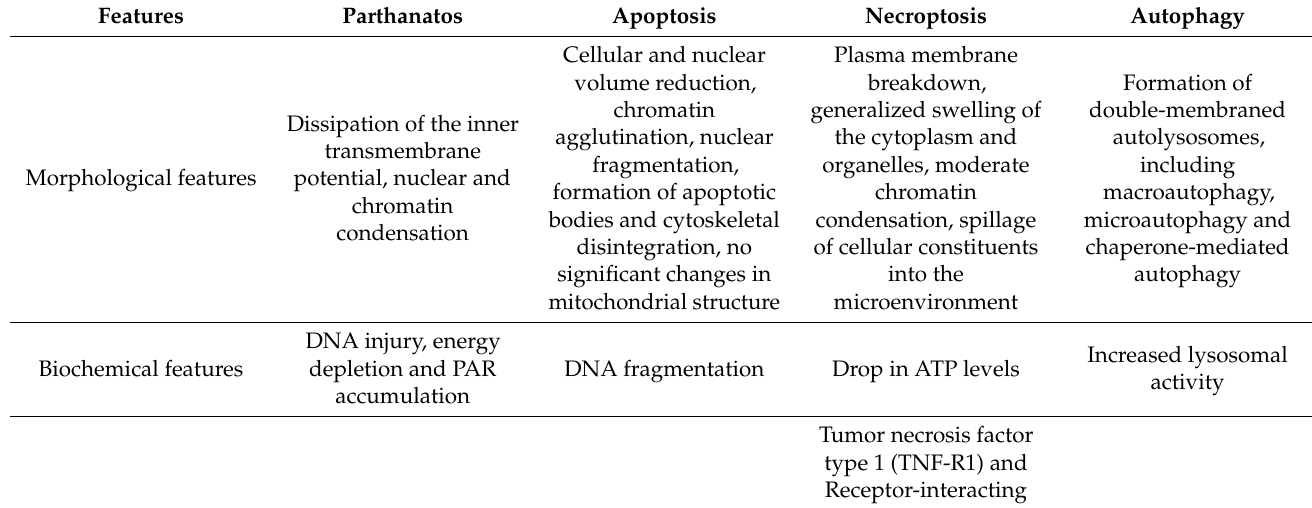
Table 1. Similarities and differences between apoptosis, necrosis, autophagy, and